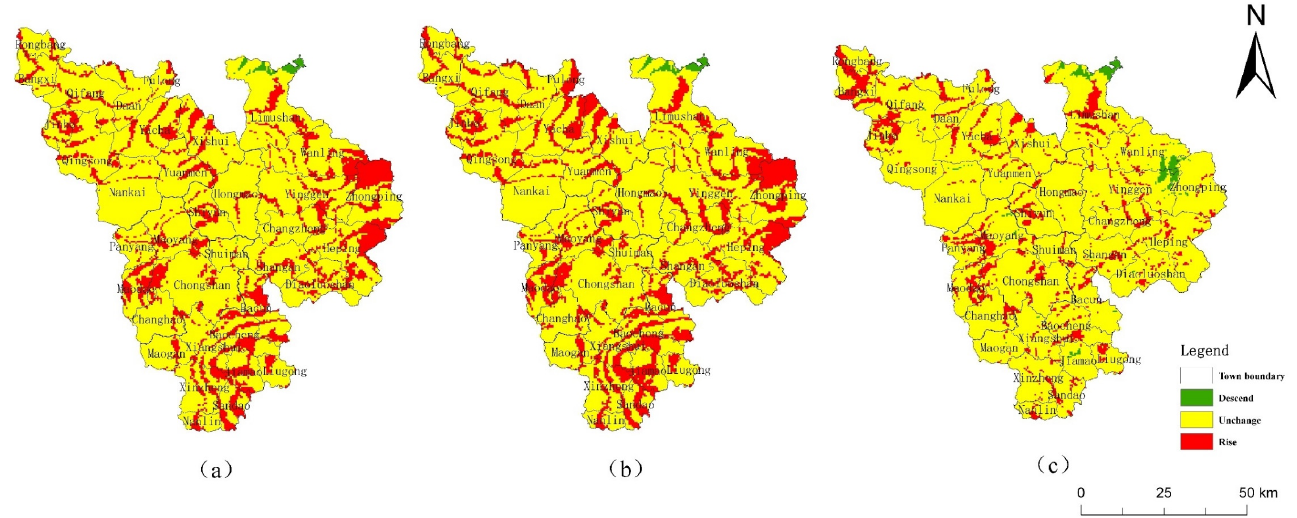
Figure 7. Spatial changes of landscape ecological risk from 2018 to 2026. ( a ) NDS, ( b ) EDS, ( c ) EPS.